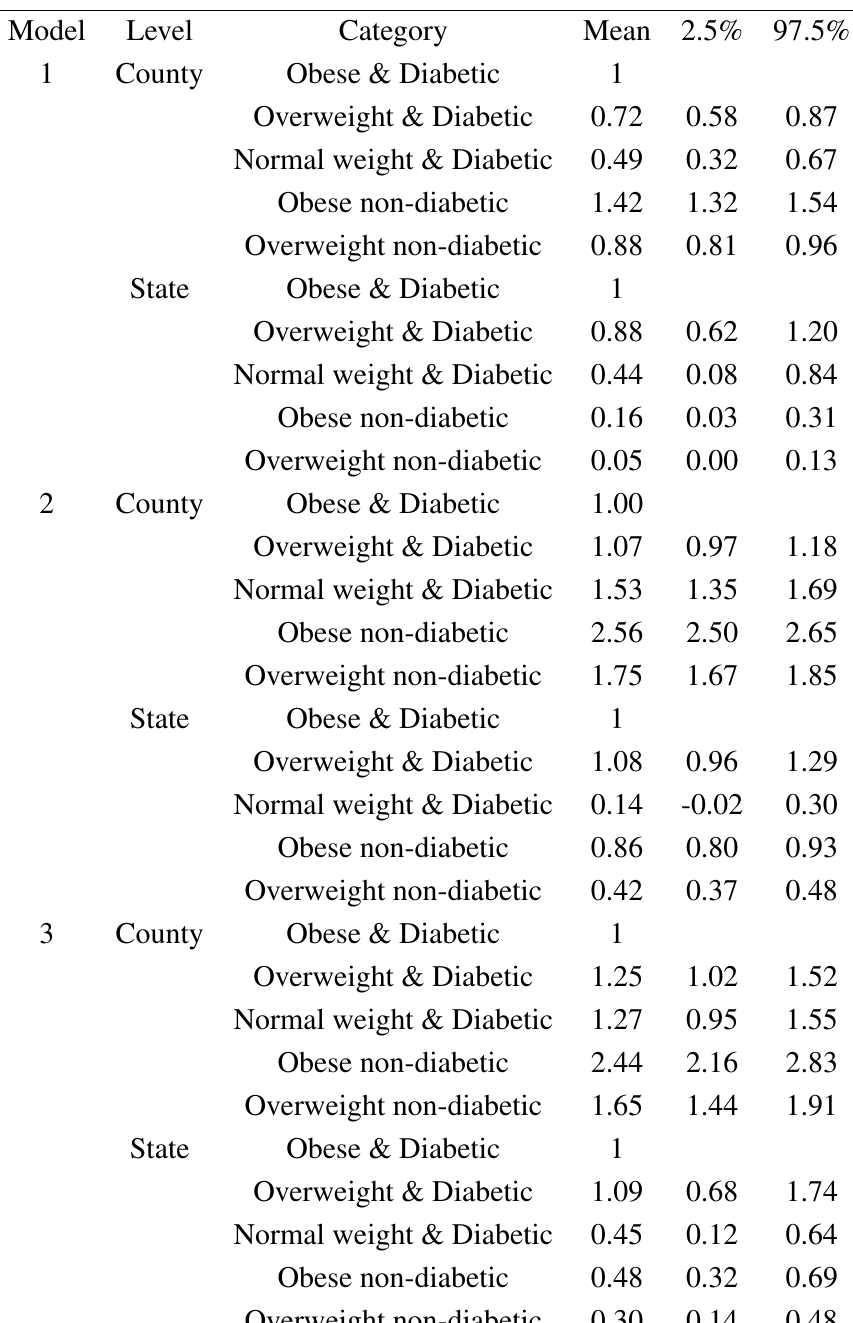
Table 5 . Loadings on shared latent effects, by